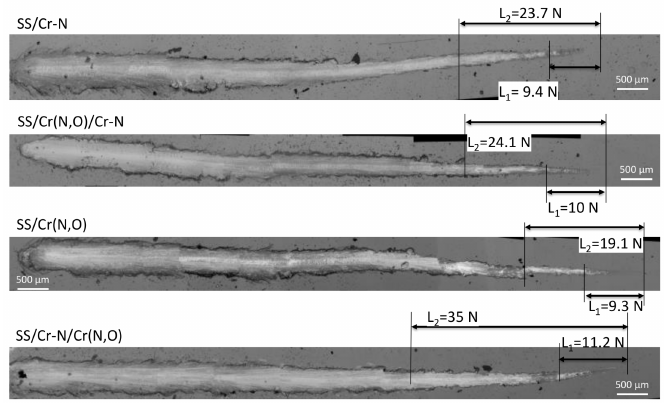
Figure 5. Scratch traces of Cr-based coatings deposited on 304 SS substrate.